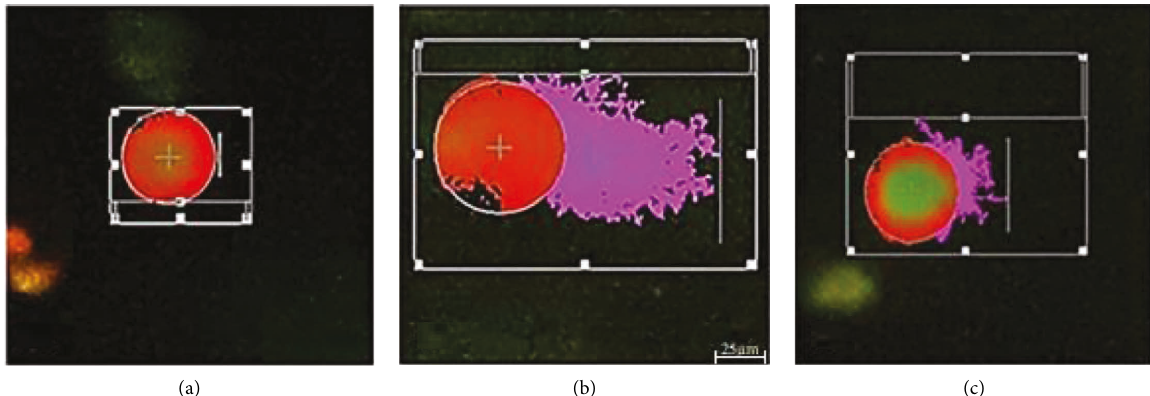
Figure 3: Demonstrating classes of comets: (a) no damage: control group (without the tail); (b) increased DNA damage: haloperidol-treated group; (c) decreased DNA damage: haloperidol+carvacrol treated group. Scale bar:25 µ m.